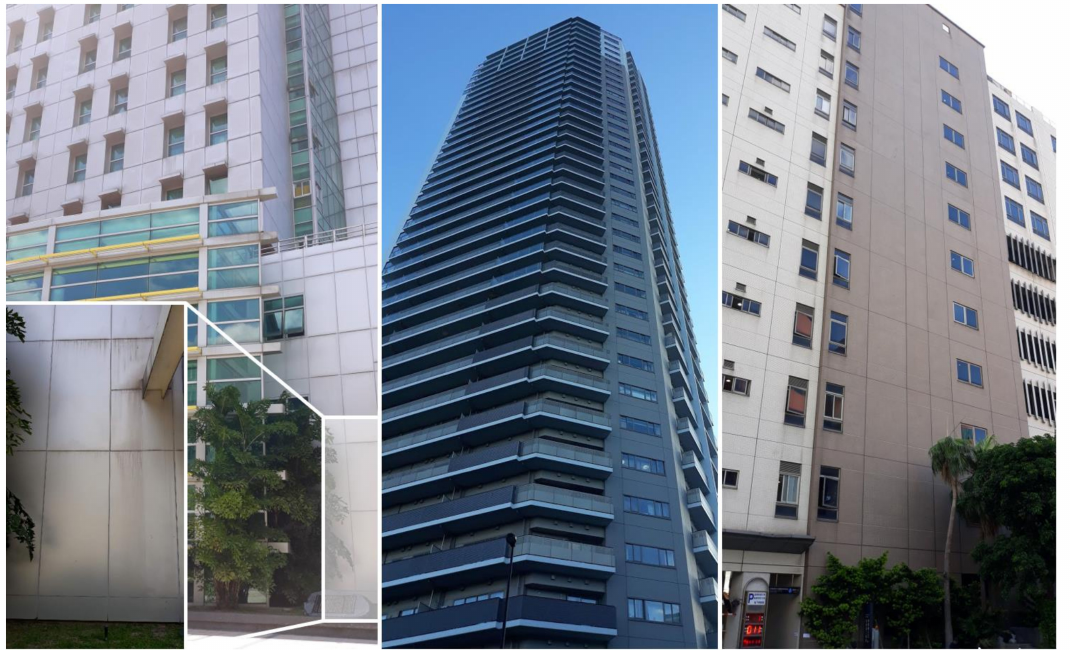
Figure 1. An illustrative example of sealed joints which are several meters long in façade